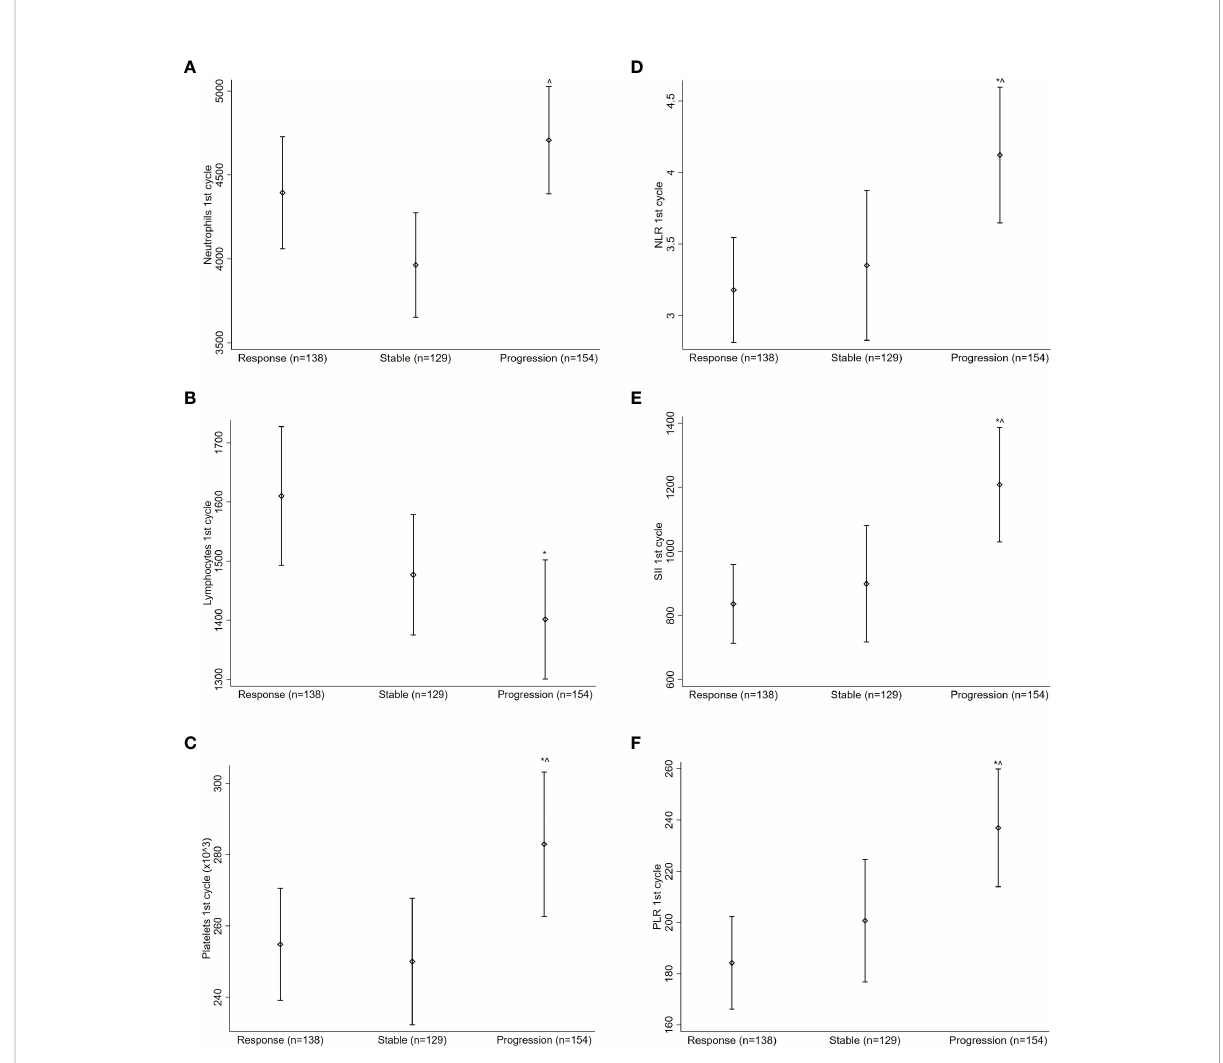
FIGURE 2 The baseline ACC and IR values according to the disease response to nivolumab.Neutrophils (A) , lymphocytes (B) , platelets (C) , NLR (D) , SII (E) and PLR (F) were assessed.*Signi fi cant differences compared with response (R); ^Signi fi cant difference compared with stable disease (S); 2A: p = 0.11 for S vs. R; p = 0.17 for progression (P) vs. R; p = 0.003 for P vs. S; 2B: p = 0.14 for S vs. R; p = 0.018 for P vs. R; p = 0.33 for P vs. S; 2C: p = 0.72 for S vs. R; p = 0.044 for P vs. R; p = 0.036 for P vs. S; 2D: p = 0.61 for S vs. R; p = 0.012 for P vs. R; p = 0.029 for P vs. S; 2E: p = 0.60 for S vs. R; p = 0.003 for P vs. R; p = 0.014 for P vs. S; 2F: p = 0.31 for S vs. R; p = 0.003 for P vs. R; p = 0.032 for P vs. S; p values were adjusted for multiple comparisons using the false discovery rate